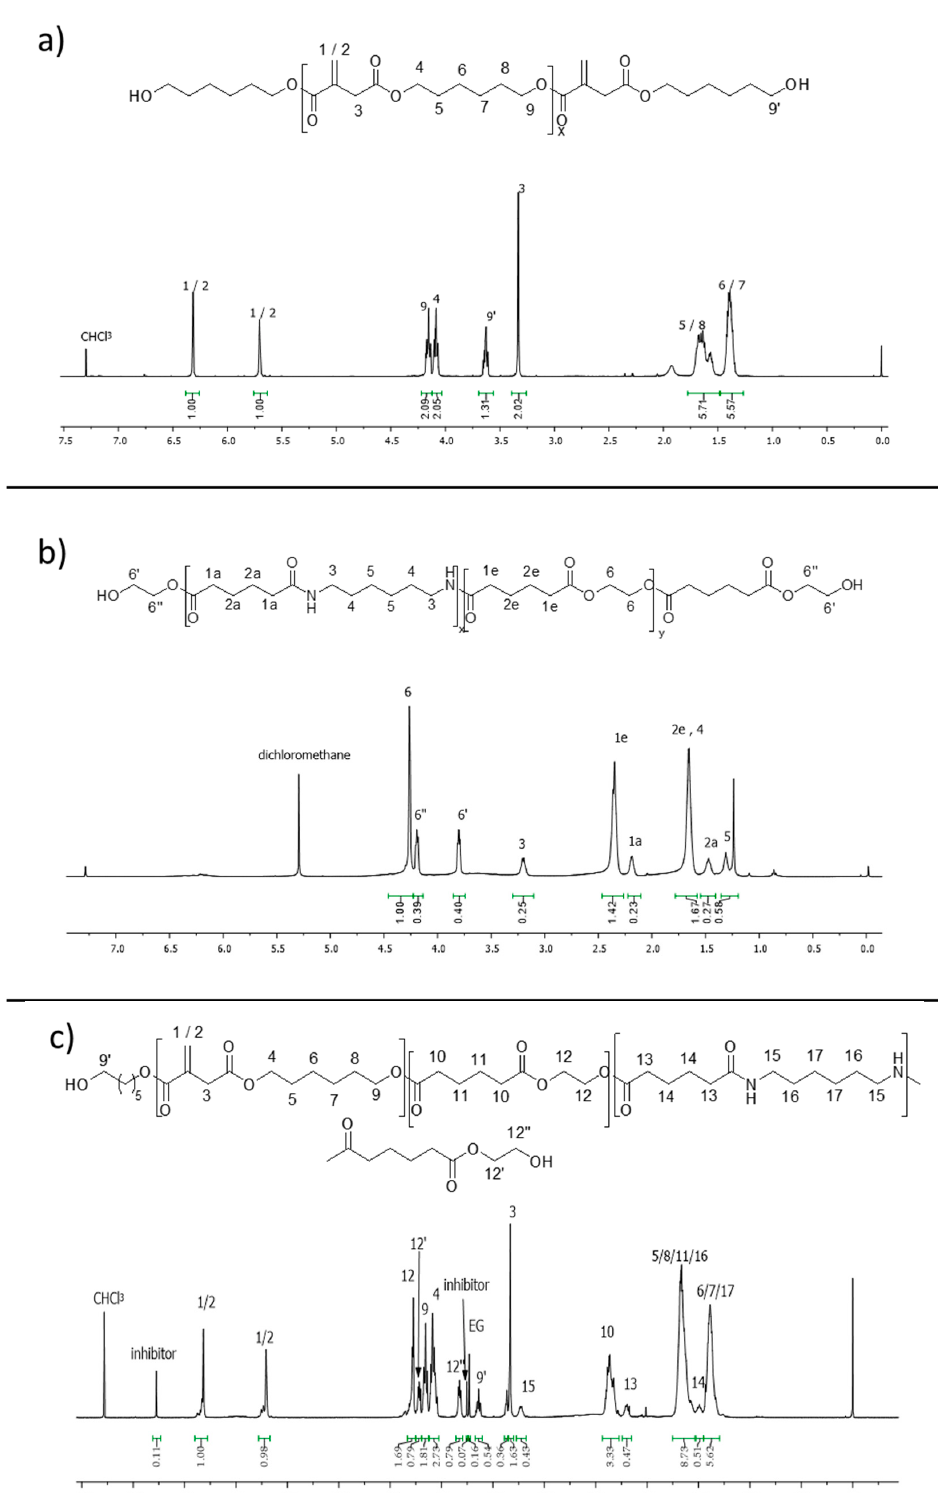
Figure 1. 1 H NMR spectra of a ) Oligoester (OE), b ) Oligoester amide (OEA), c ) and